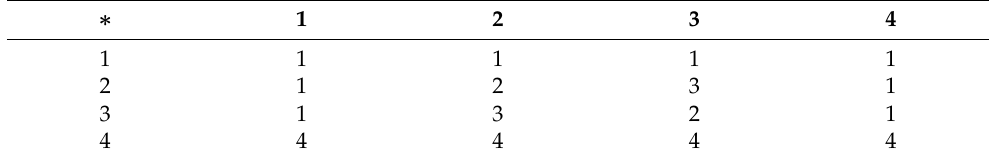
Table 1. A TA-groupoid of Example 1.